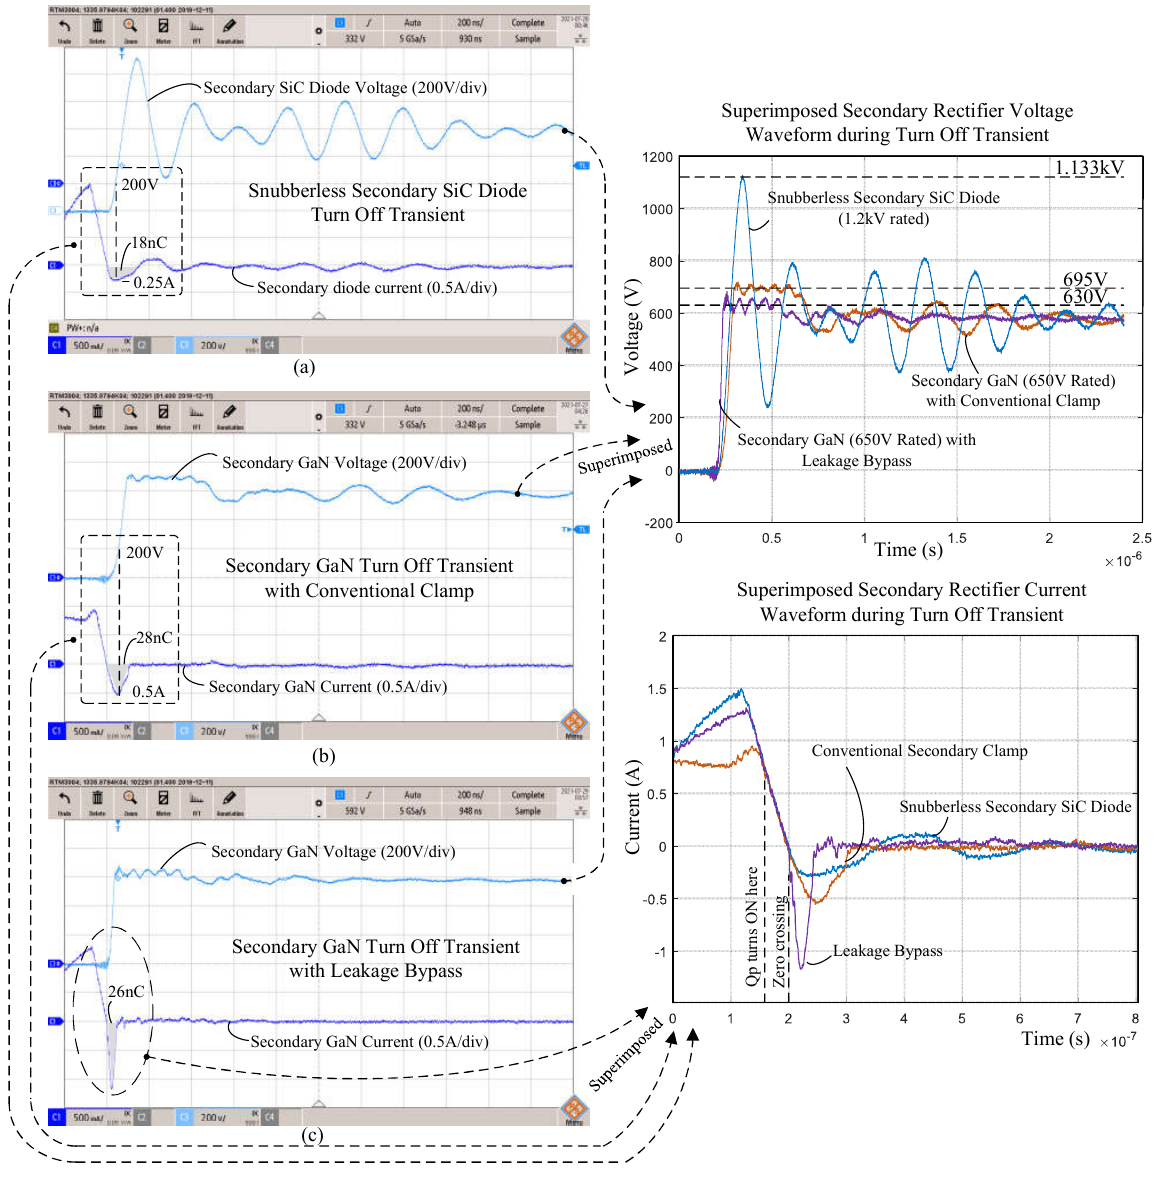
Figure 17. Experimental result of current and voltage of secondary rectifier ( a ) with snubber-less 1.2 kV SiC Diode C4D02120 ( b ) with conventional active clamp 650 V GaN GS-065-011-1-L ( c ) with leakage bypass 650 V GaN GS-065-011-1-L.